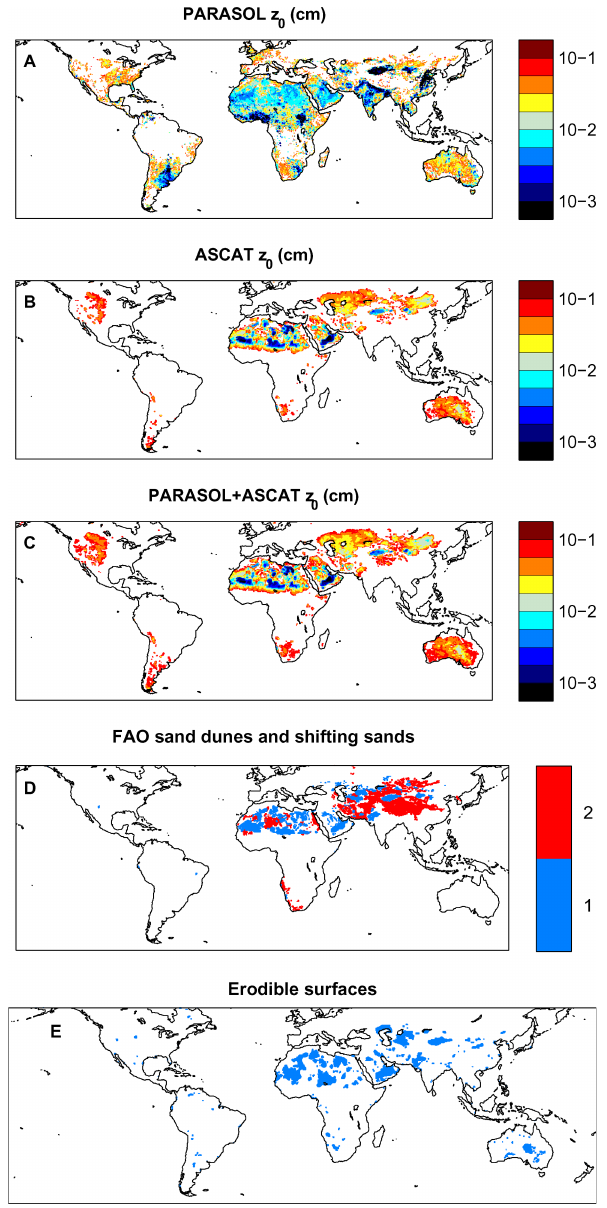
Fig. 6. (A) z 0 (cm) estimated from PARASOL only, (B) z 0 (cm) es- timated from ASCAT only, (C) z 0 (cm) estimated from both PARA- SOL and ASCAT (when no PARASOL data, z 0 derived from AS- CAT only), (D) map of the FAO for “sand dunes and shifting sands” (blue) and “rock debris and desert detritus” (red) (FAO, 2003), (E) map of the erodible surfaces (Koven and Fung, 2008, Fig. 5a).